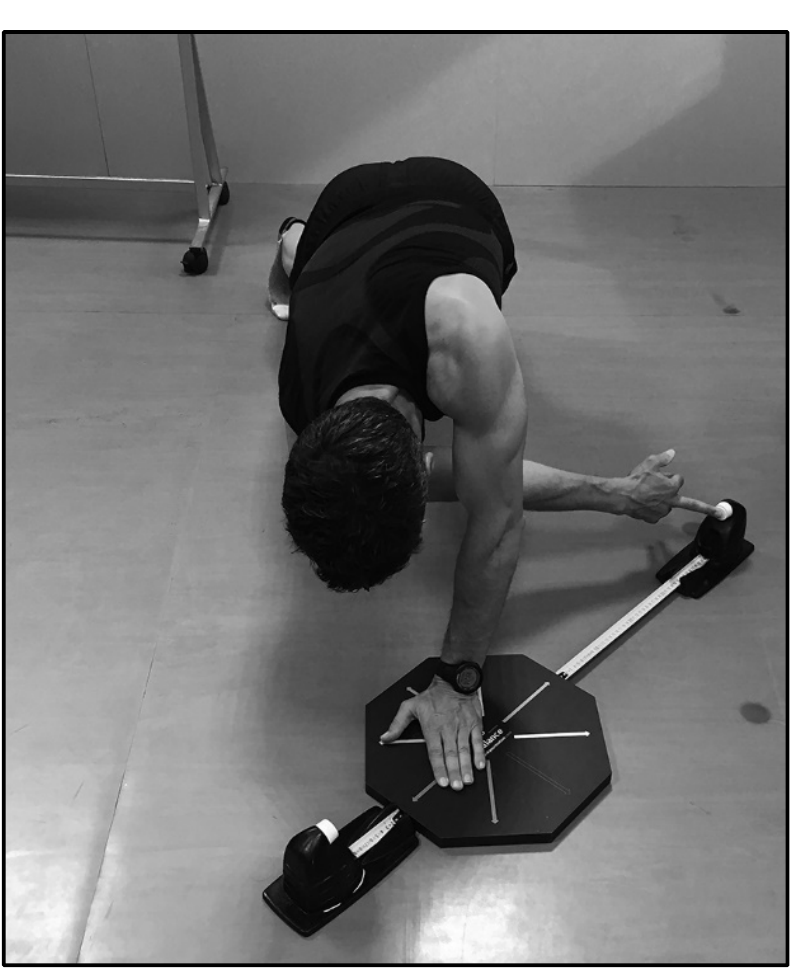
Figure 5. OB in the inferolateral direction.